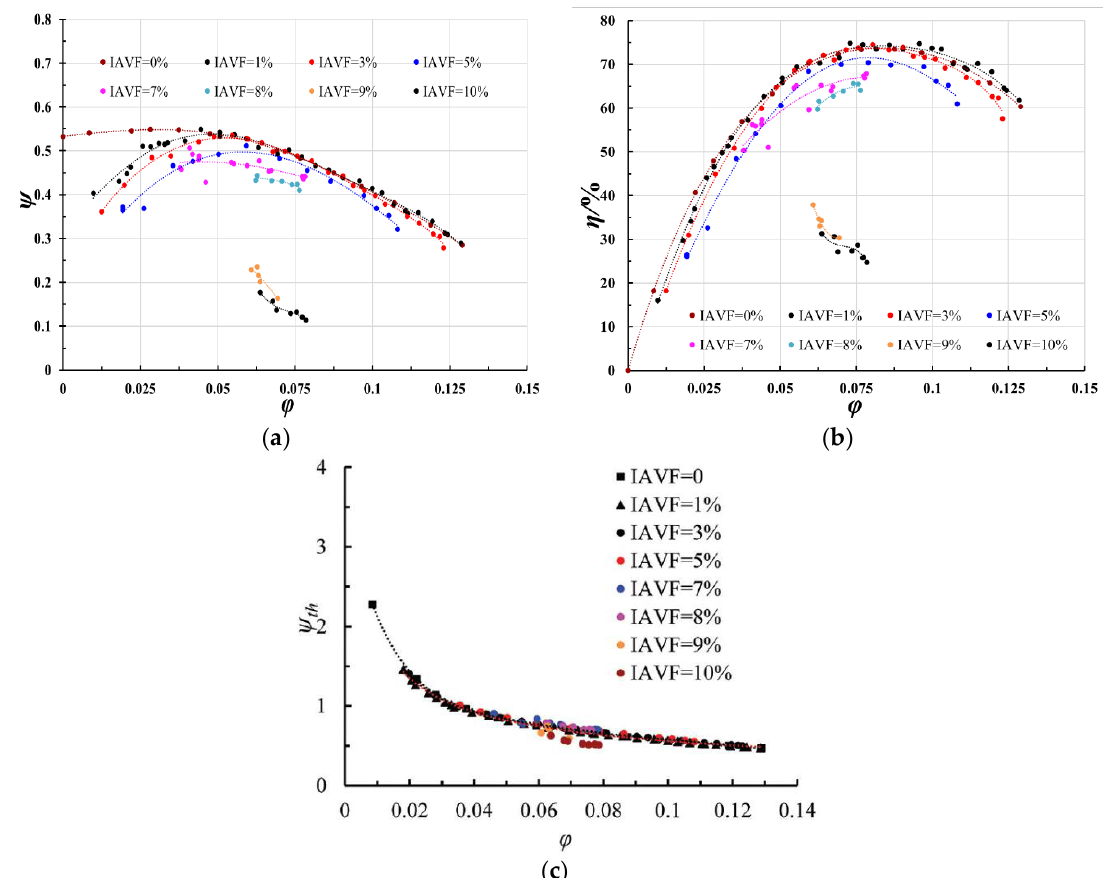
Figure 5. Pump performance curves at 2910 rpm rotational speed [27–29]. ( a ) Flow coefficient against head coefficient, ( b ) flow coefficient against efficiency, ( c ) theoretical head curve.